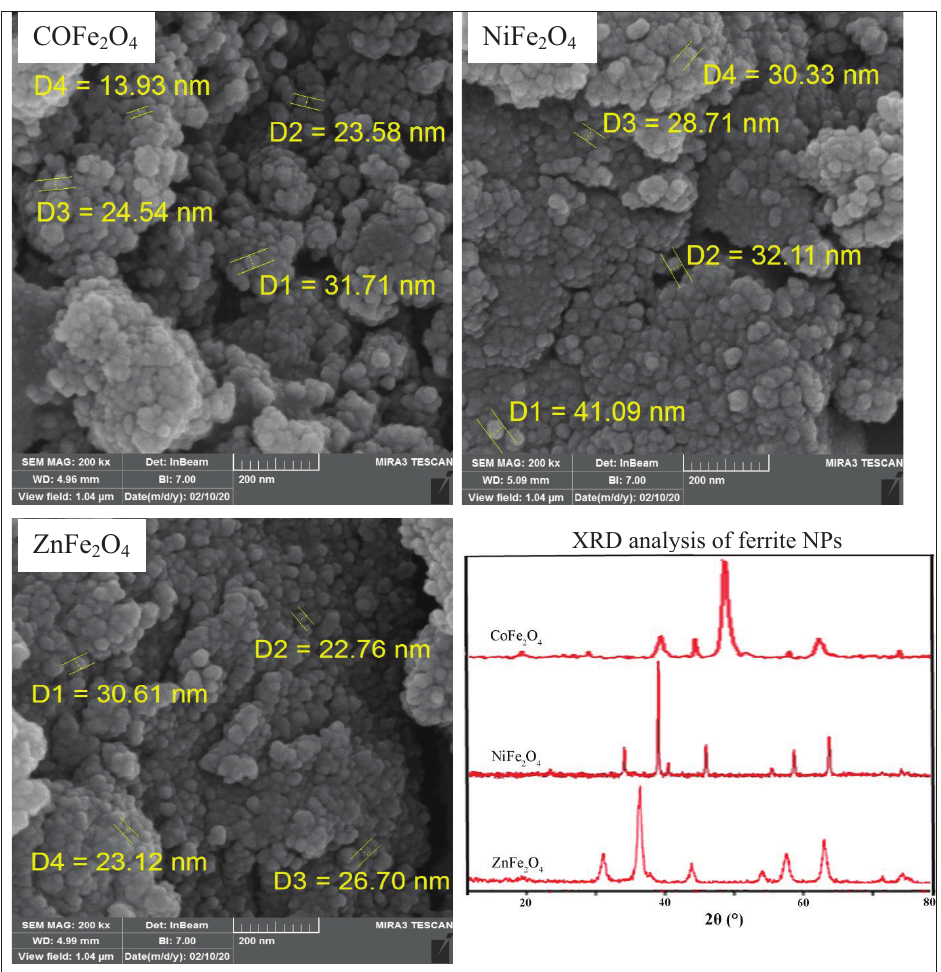
O , NiFe O , and ZnFe 2 4 2 4